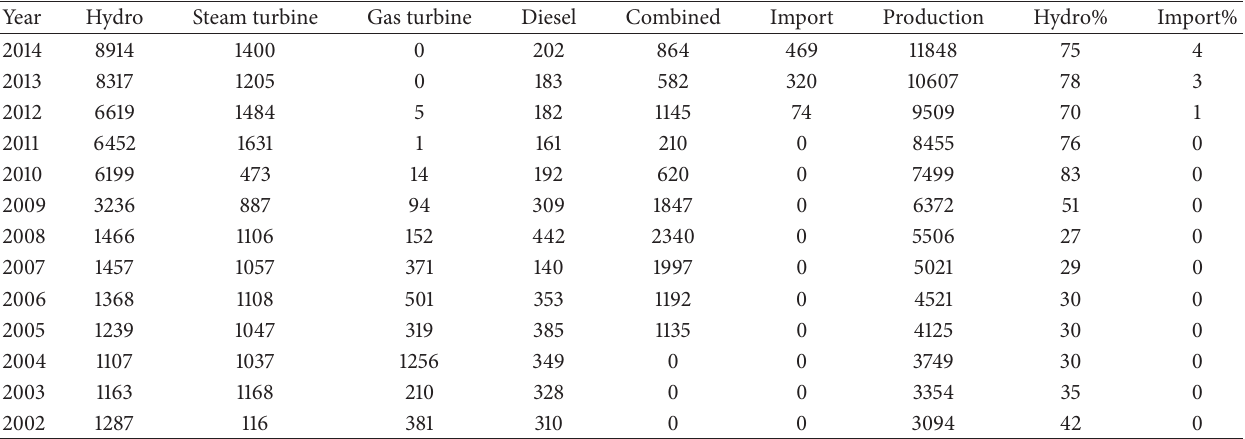
Table 4: Electric power profile (GWh).